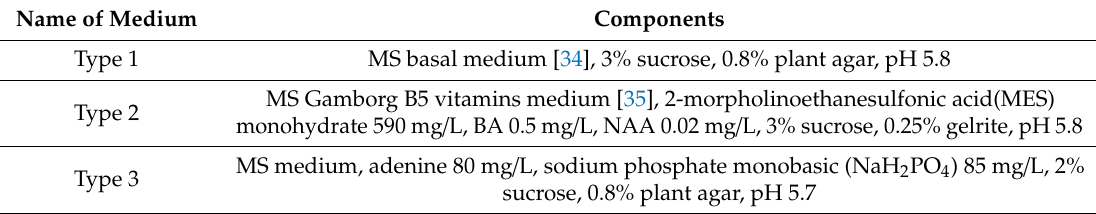
Table 2. Components of the three types of media used for the induction of normal and vitrified leaves